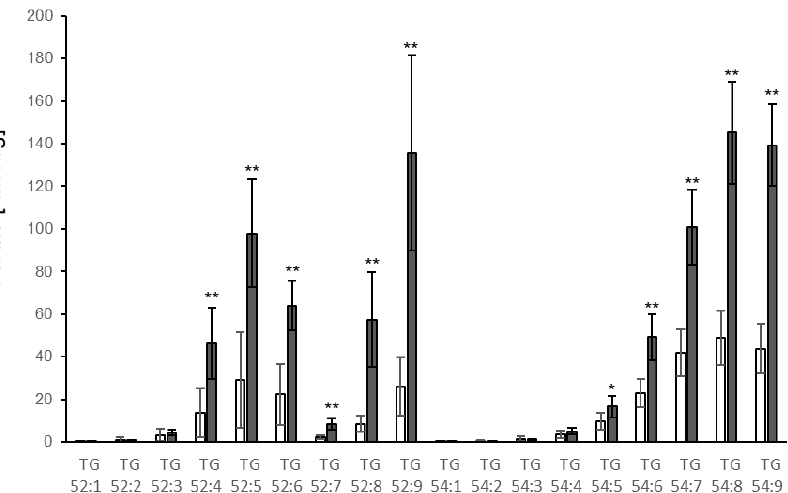
Figure 4. Accumulation of different TG species in Col-0 leaves 1 d after spraying of leaves with P. syringae (dark grey bars) or mock (white bars). TG species are characterized by their total number of acyl carbons and the number of double bonds. TG levels [nmol/g dry weight] shown represent the mean of five biological replicates ± sd. Asterisks indicate significant differences between the P. syringae treatment and the mock treatment (* p < 0.05; ** p <